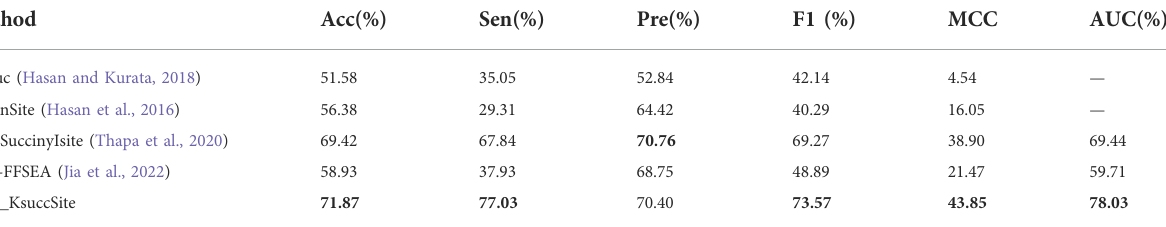
TABLE 3 Comparison of Deep_KsuccSite with existing predictors of GPSuc, SuccinSite, and DeepSuccinyIsite on the independent test data.